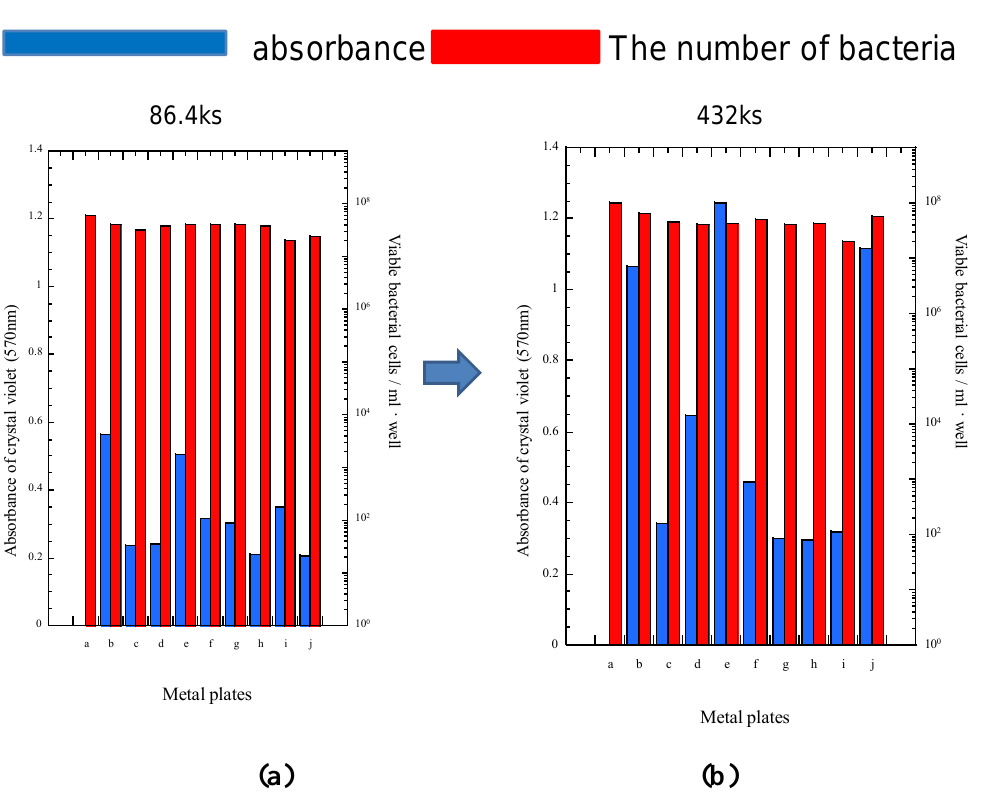
Figure 6. Biofilm formation of Pseudoalteromonas carageenovara on surfaces of various specimens. (a) immersion time: 24 hours; (b) immersion time: 120 hours.